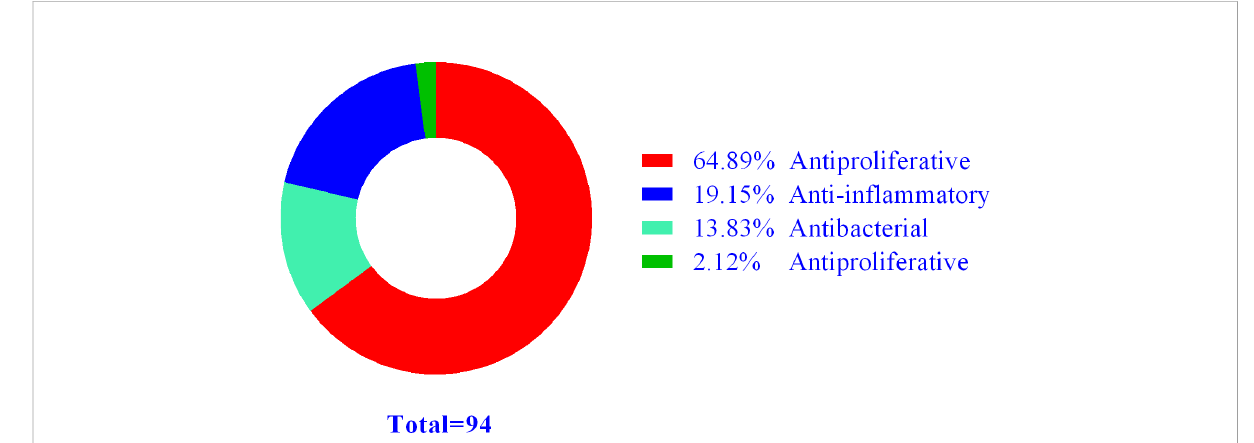
FIGURE 2 Biological activity distribution of active metabolites in Eutypella